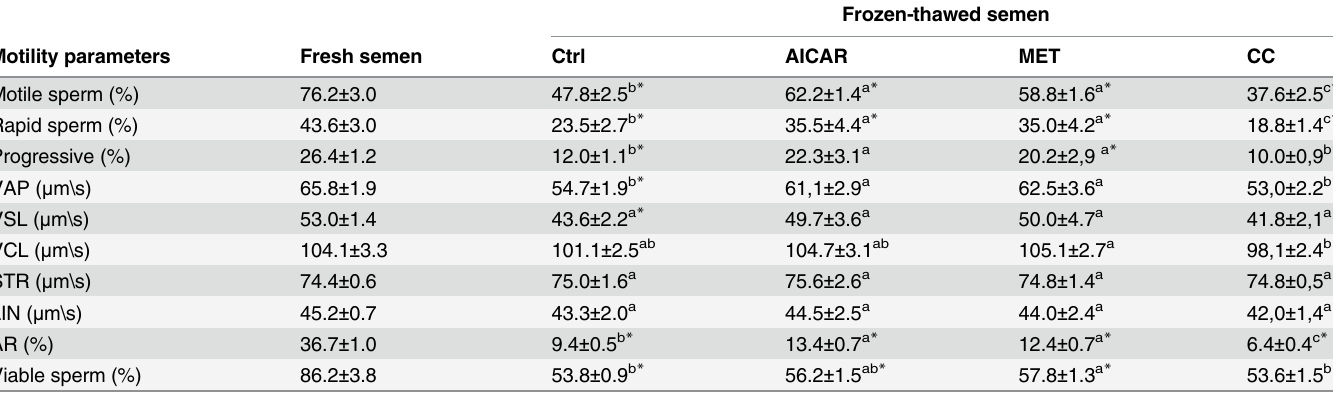
Table 2. Effect of AICAR, MET or CC treatment on fresh sperm and following cryopreservation.